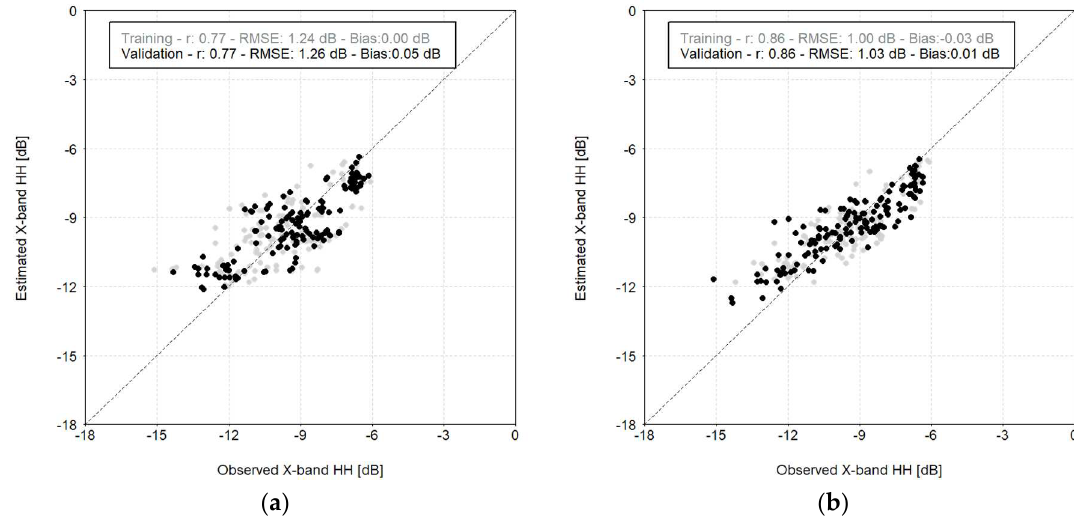
Figure 7. Comparison between simulated and observed backscattering coefficients in the X-band with HH polarization using MLR ( a ) or RF ( b ) statistical algorithm. The gray dots represent the estimates obtained on the training subset, while the black dots come from the validation subset.